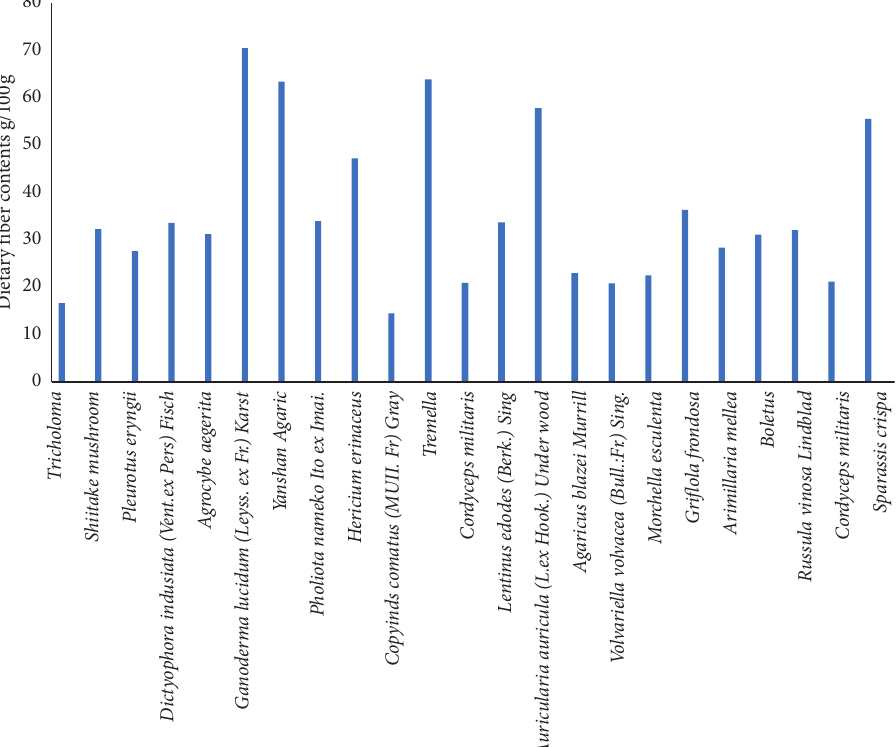
Figure 5: Dietary fiber contents of 23 kinds of edible